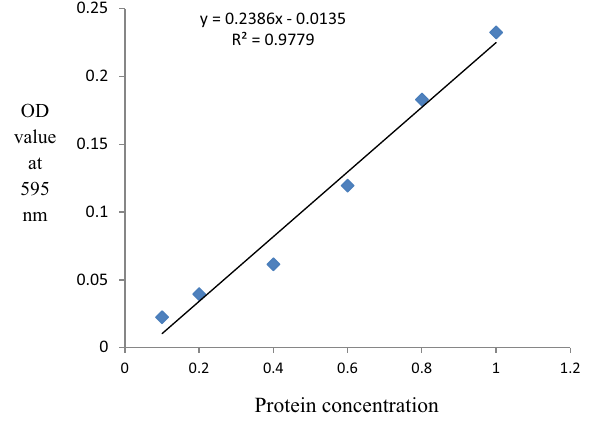
Figure 1. Standard curve of the Bradford assay.